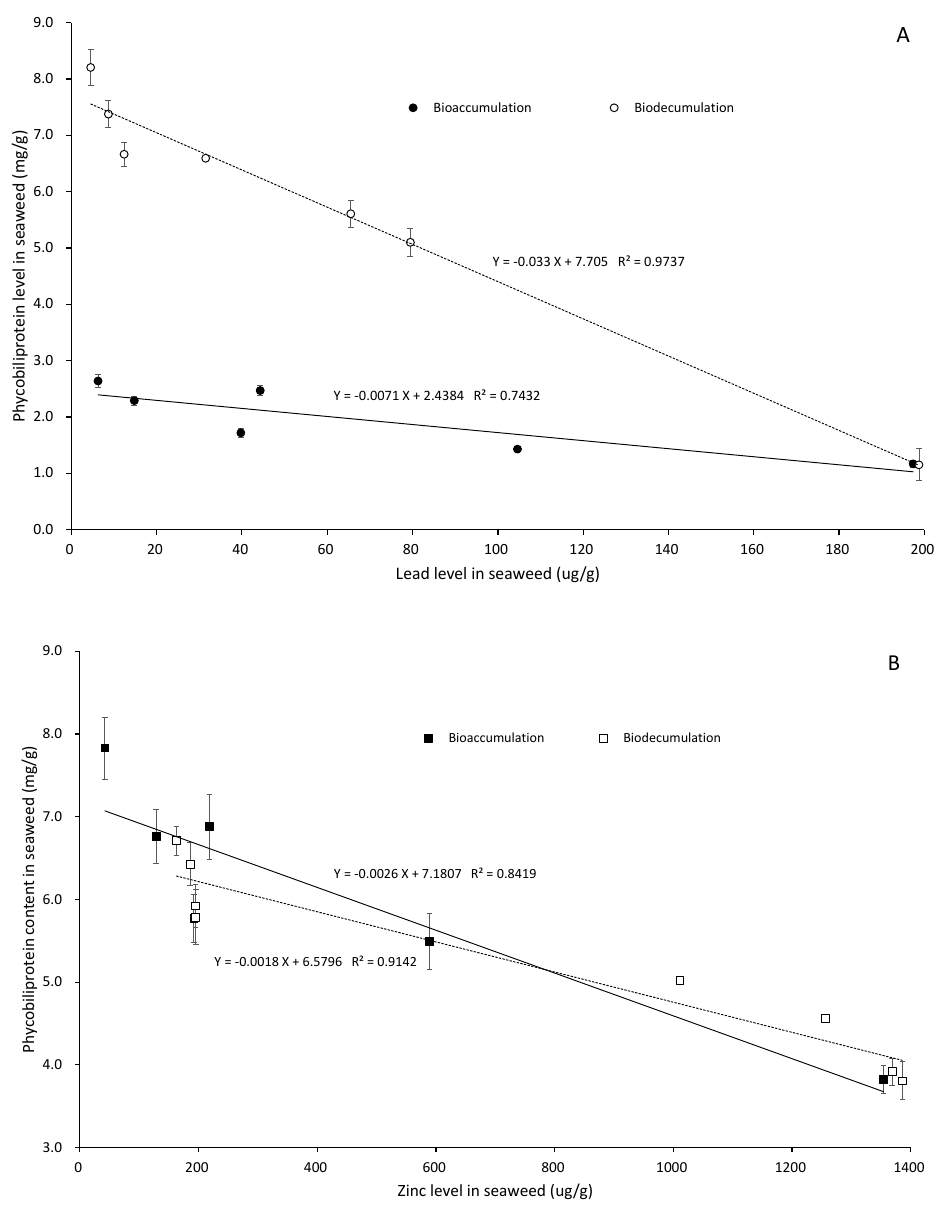
Figure 5. The relationship between phycobiliproteins and bioaccumulation and biodecumulation of lead ( A ) and zinc ( B ) in seaweed.